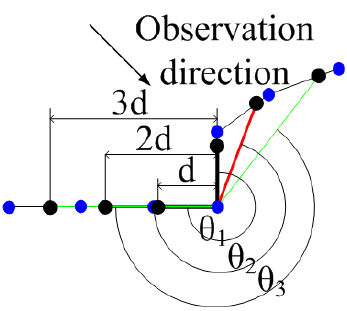
Figure 6. Feature descriptor. Blue points denote raw laser observations and black points indicate the points that are d , 2 d and 3 d meters away from the extracted